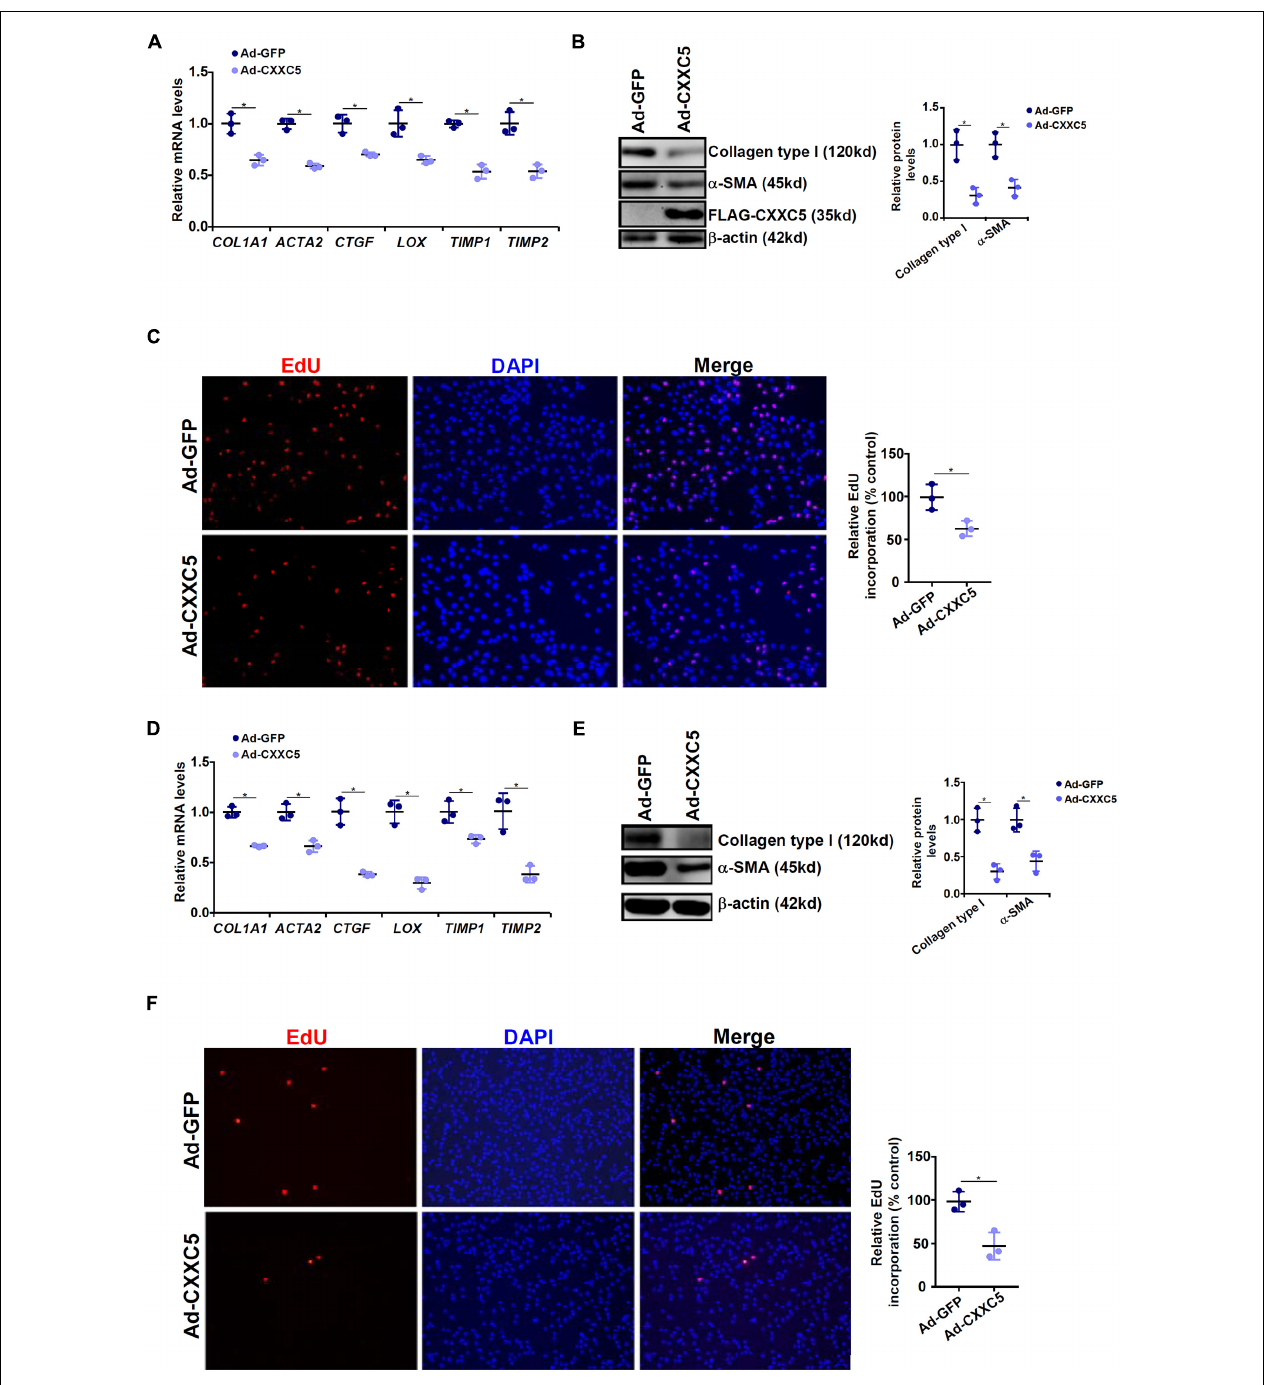
FIGURE 2 | CXXC5 over-expression suppresses HSC activation. (A–C) LX-2 cells were infected with adenovirus carrying CXXC5 expression vector (Ad-CXXC5) or GFP (Ad-GFP). Gene expression levels were examined by qPCR and Western. Cell proliferation was measured by EdU staining. (D–F) Primary murine hepatic stellate cells were infected with adenovirus carrying CXXC5 expression vector (Ad-CXXC5) or GFP (Ad-GFP). Cell proliferation was measured by EdU staining. All experiments were repeated three times and one representative experiment is shown. * p < 0.05.